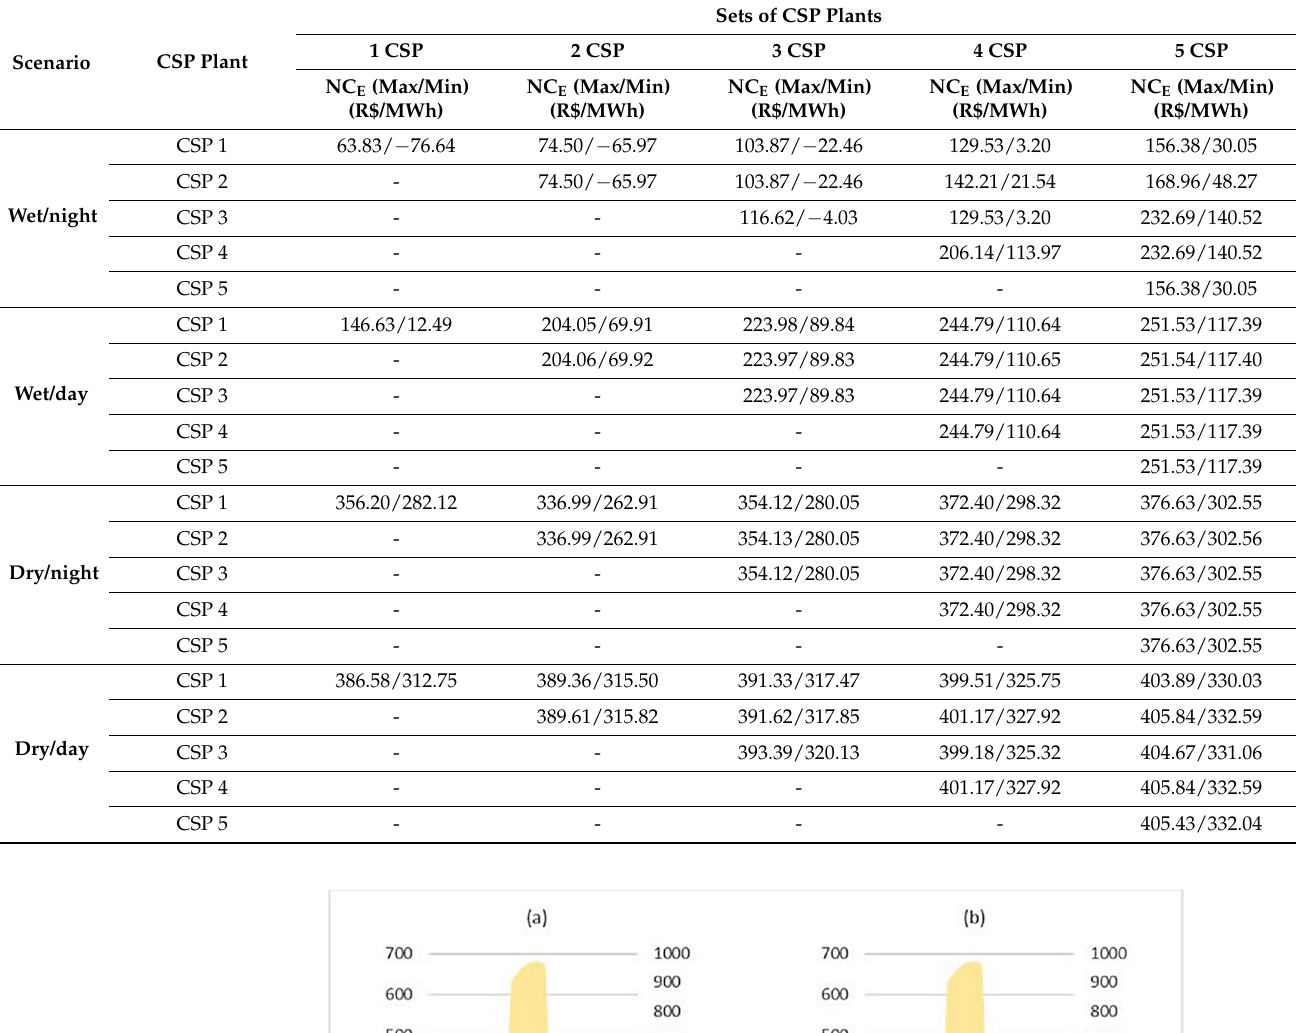
Table 8. Net cost of each CSP plant in the scenarios and sets of plants considered.